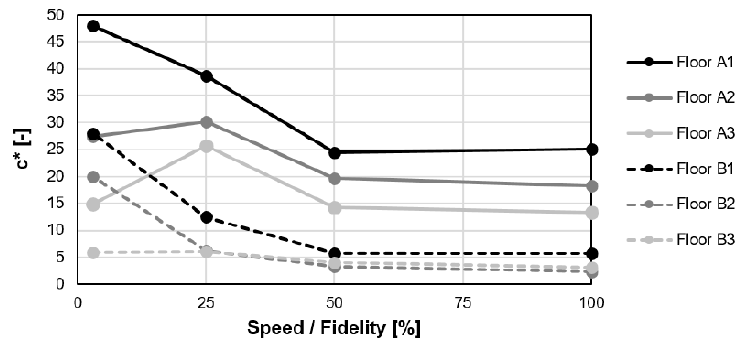
Figure 7. Comparison of computed normalized concentration values using different speed/fidelity settings.